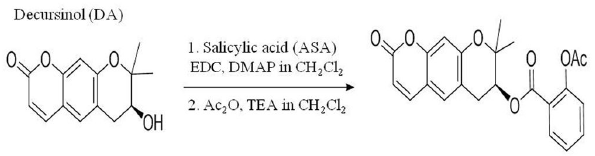
Figure 1. Synthesis of